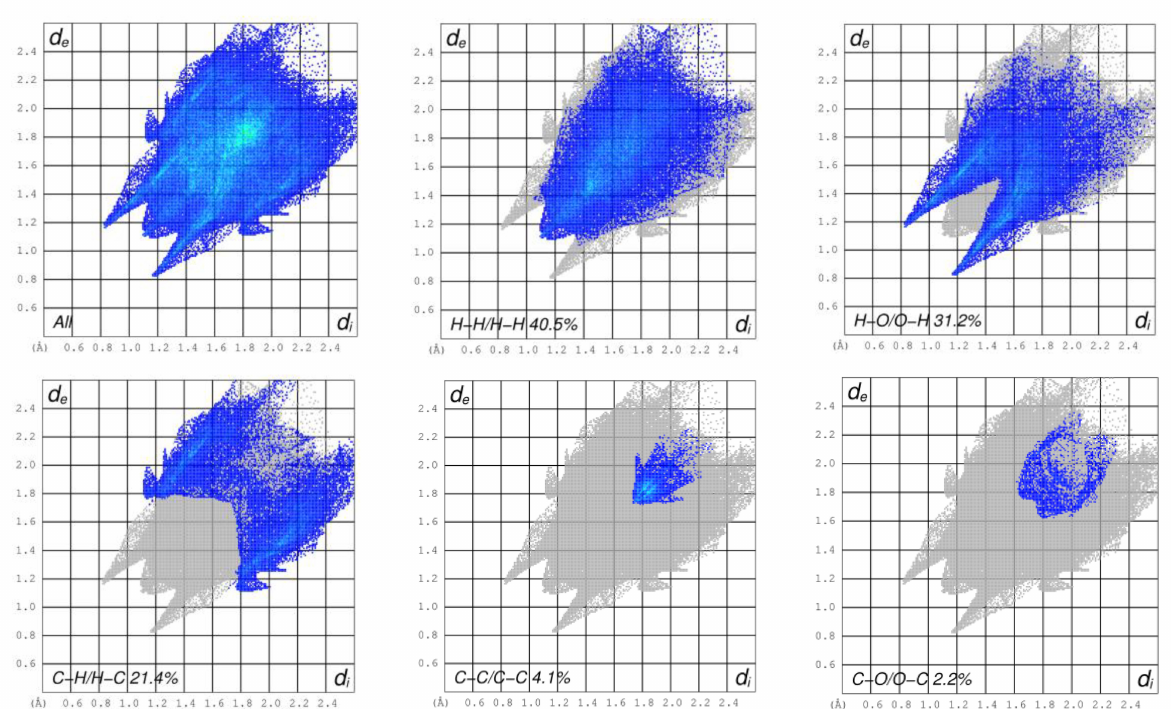
Figure 3. The 2D fingerprint plots of interatomic interactions for compound showing the percentages of contacts contributed to the total Hirshfeld surface area of the molecules.